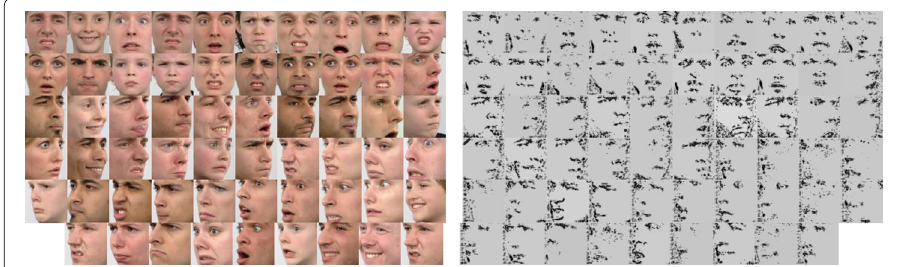
Fig. 8 Visualization of the features in facial recognition. Left: original images. Right: features